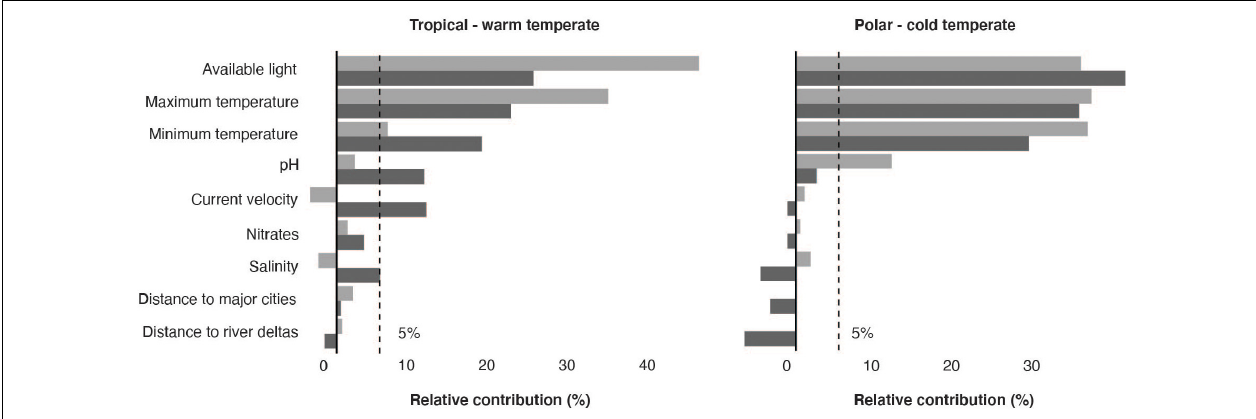
FIGURE 1 | Benthic environmental predictors used in adaptive boosting (light gray) and boosted regression trees (dark gray) and their relative contribution to the models’ predictions for tropical—warm temperate and polar—cold temperate affiliated